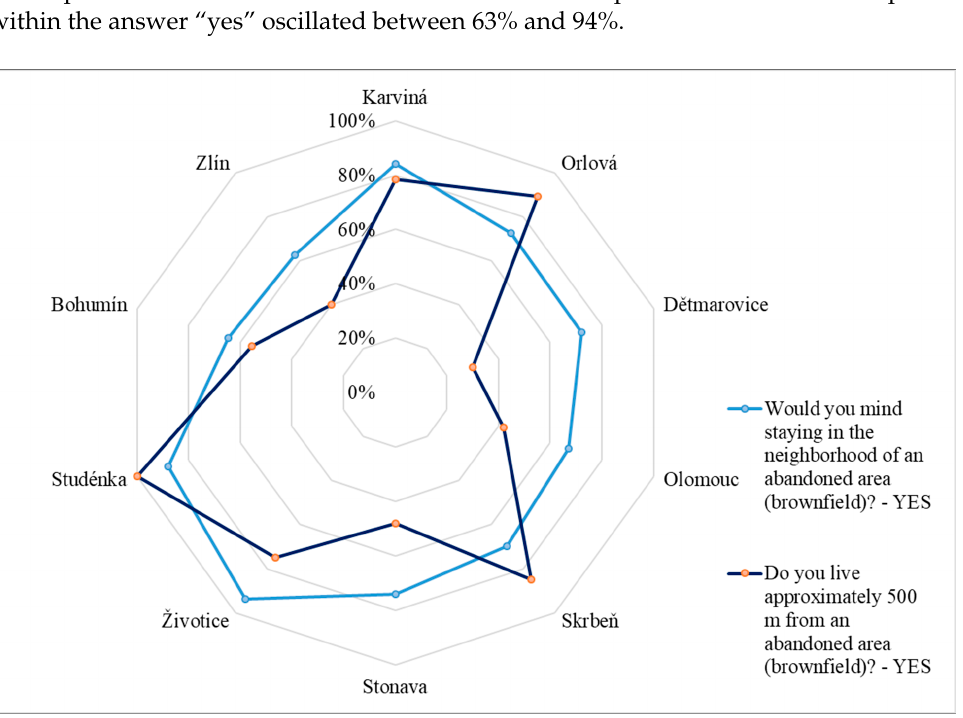
Figure 2. The actual situation and willingness to live in the neighbourhood of brownfields in 10 surveyed communities. Source: own survey (n = 1,152). Note: original data are presented in Appen- dix A. 10 surveyed communities. Source: own survey (n = 1152). Note: original data are presented in Appendix